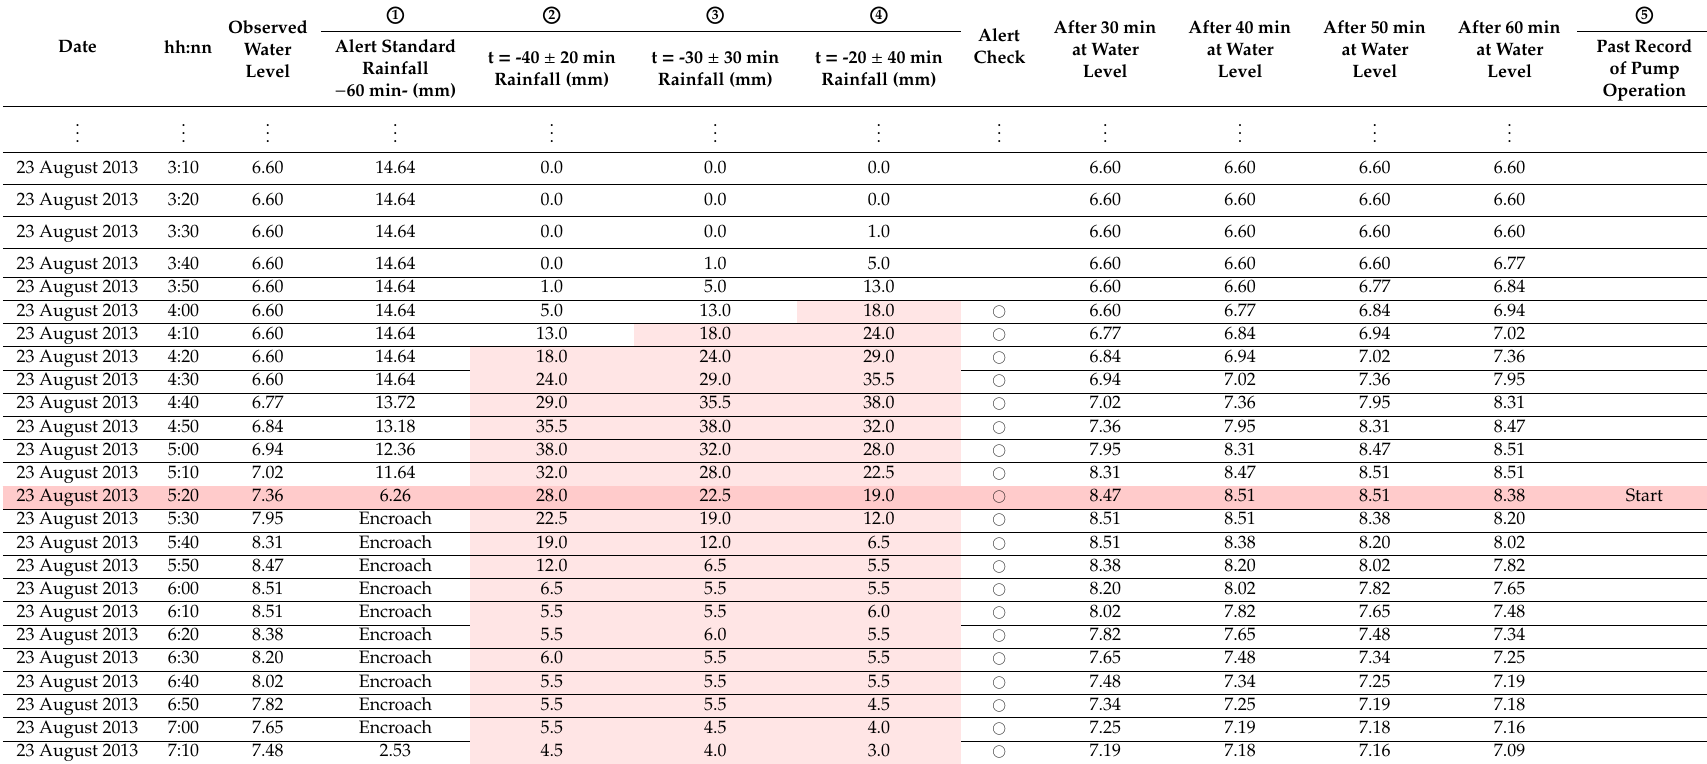
Table 12. Comparison of real-time water level observations in Dorim Stream (23 August